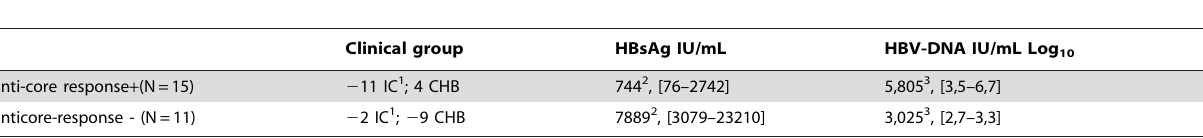
Table 2. HBsAg serum levels and HBV-DNA levels in patients with or without anti-core response.